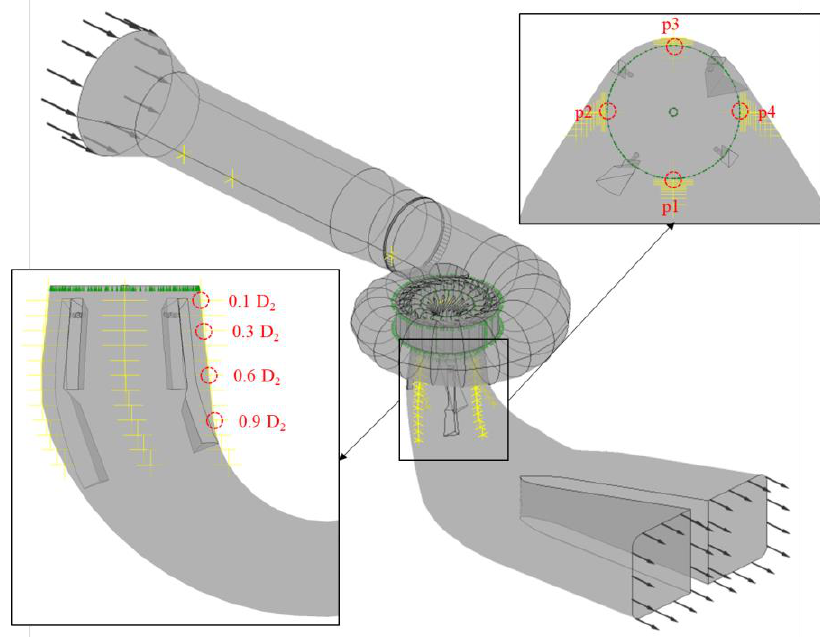
Figure 4. Pressure measurement points in the Francis turbine model.